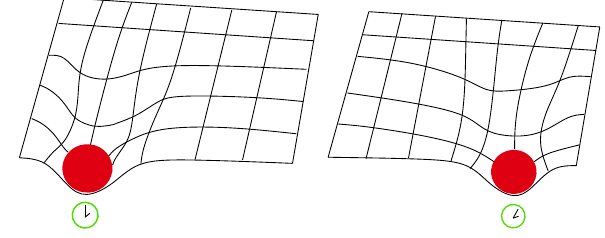
Fig. 2 Wepictoriallyrepresentthetwoconfigurations thatwearewant to superpose. They correspond to the gravitational field associated with a certain lump of matter (a star, for instance), which is located in two different places for each of the